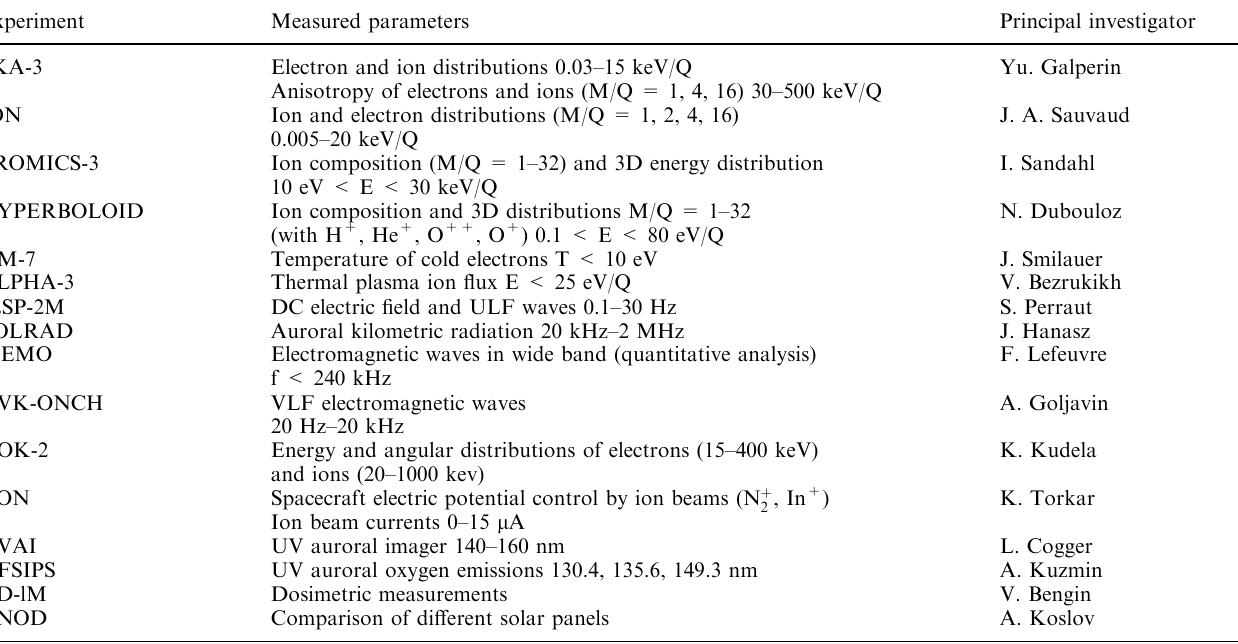
Table 1. List of experiments on the main Interball-Auroral Probe Experiment Measured parameters Principal investigator SKA-3 Electron and ion distributions 0.03–15 keV/Q